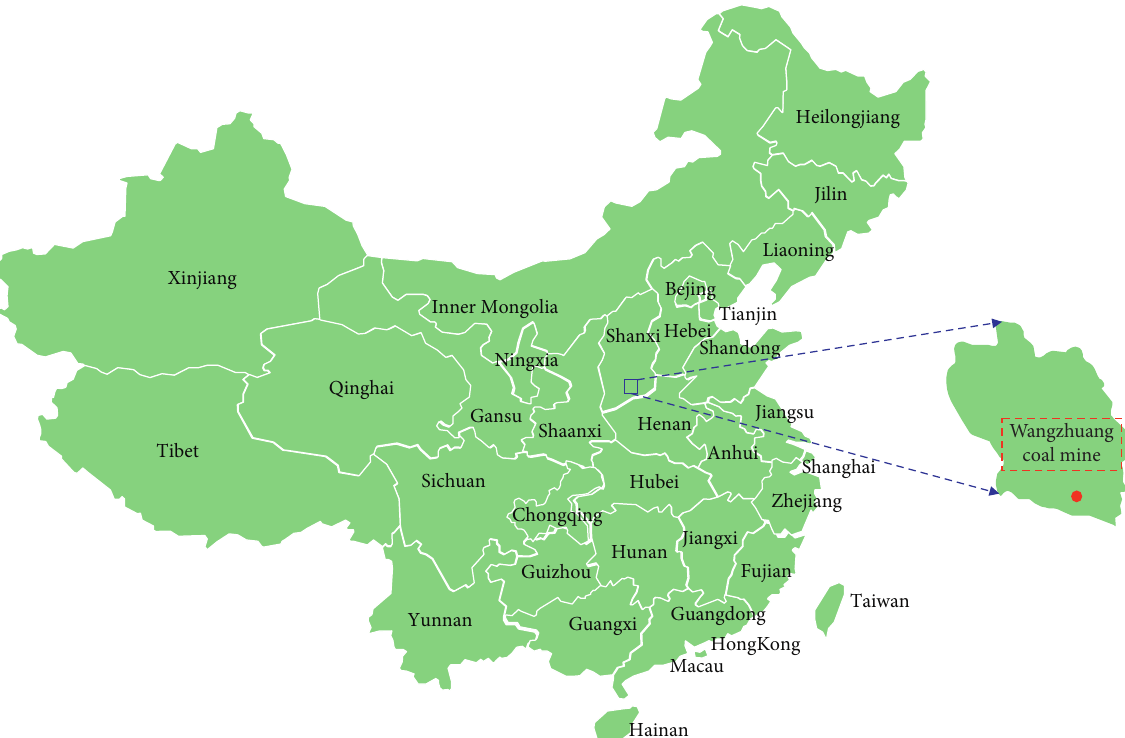
Figure 1: Location of the Lu’an mining